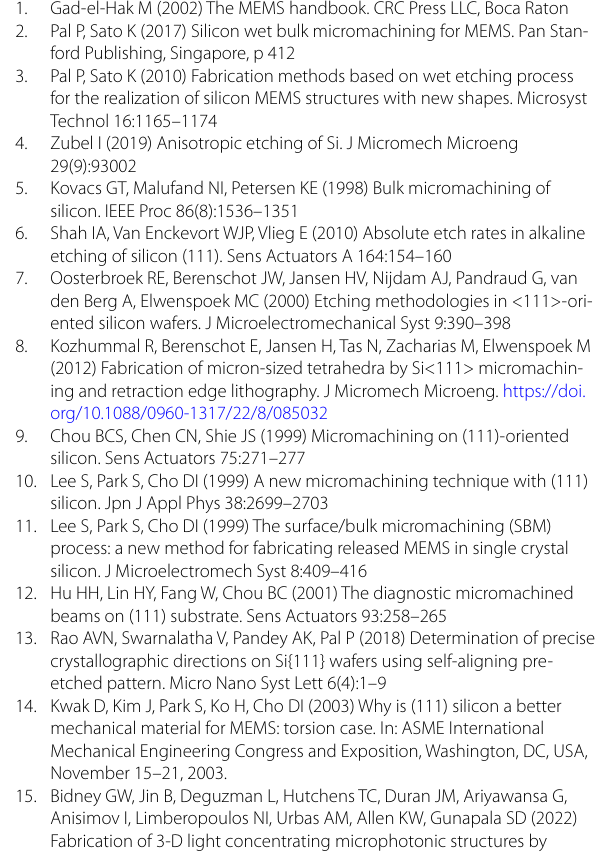
Fig. 10 Effect of etchant age (12%NH 2 OH lateral undercutting